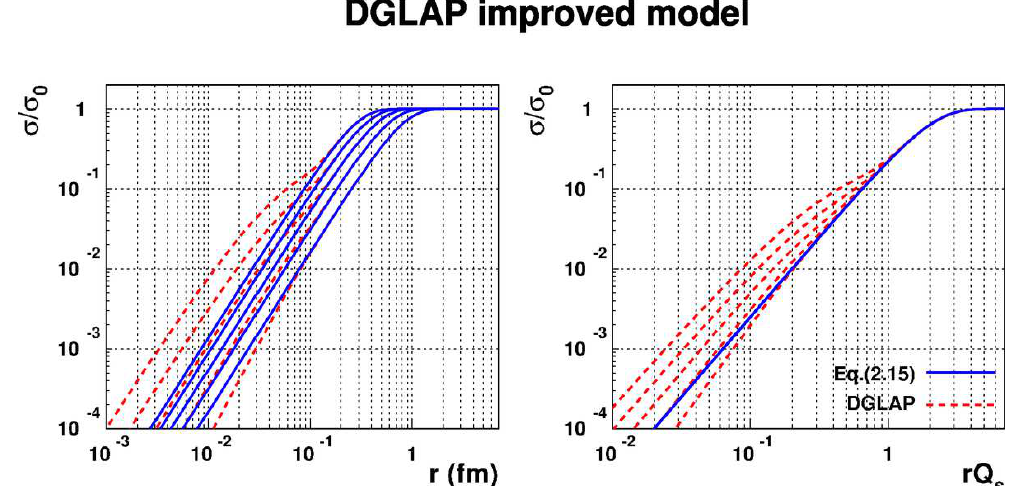
Figure 2 . Dipole cross section (2.9) for the scale (2.17) with the parameters from Fit 2 in table 3 (dashed lines) as a function r (left plot) and rQ s (right plot) for x = 10 − 6 , . . . , 10 − 2 (curves from left to right, respectively). The solid lines, corresponding to eq. (2.15), merge into one solid line in the right plot due to geometric scaling with the saturation scale (2.16). For rQ s dashed curves merge due to geometric scaling in the dipole cross section (2.9) in this region.